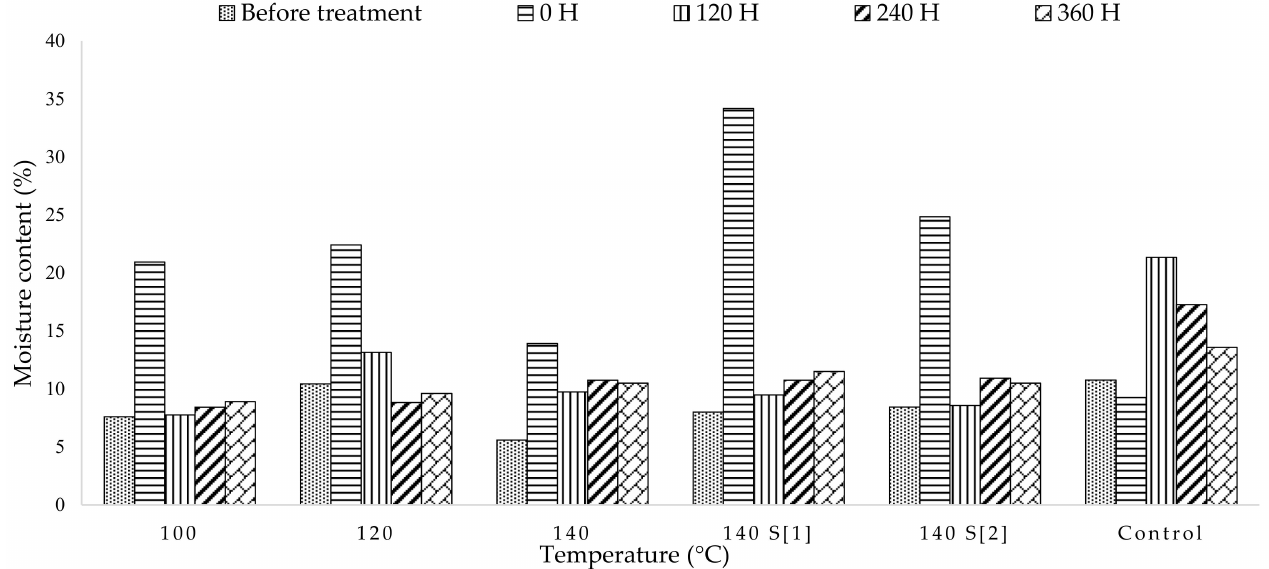
Figure 8. Correlation between equilibrium moisture content and time after